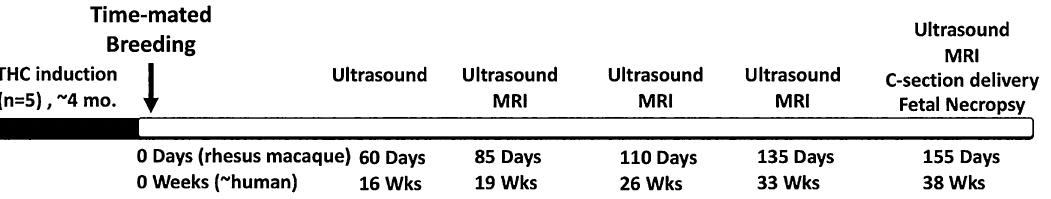
Figure 1. Study design overview. Timeline of the experimental design indicating that the THC-exposed animals underwent ~ 4 months of THC induction preconception with incremental dosing increase until reaching a dose of 2.5 g/7 kg/day (approximately a heavy medical cannabis dose) that was then maintained throughout pregnancy. The age-matched control group were administered a daily edible without THC in addition to their daily chow. Ultrasound was performed at (G60, term is ~ 168 days), and both US and MRI were performed at G85, G110 and G135, and G155 with immediate cesarean delivery following imaging at